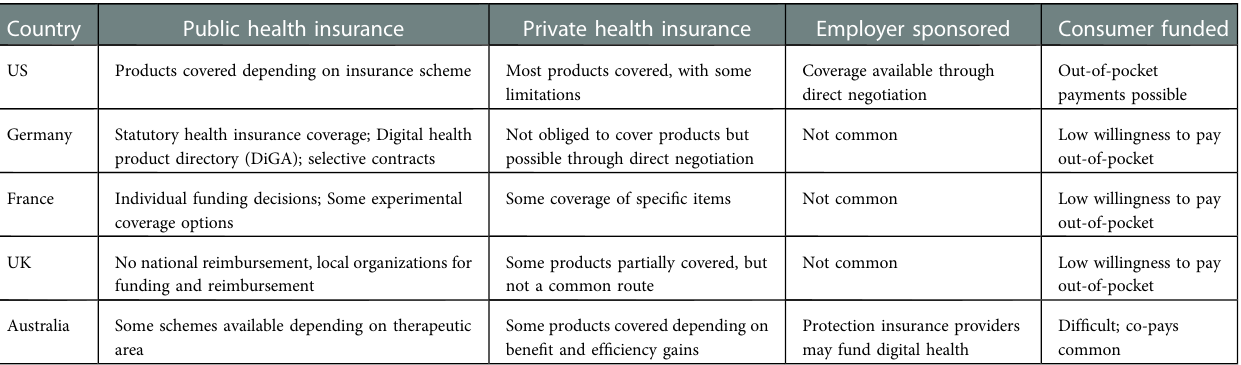
TABLE 3 Reimbursement landscape in given